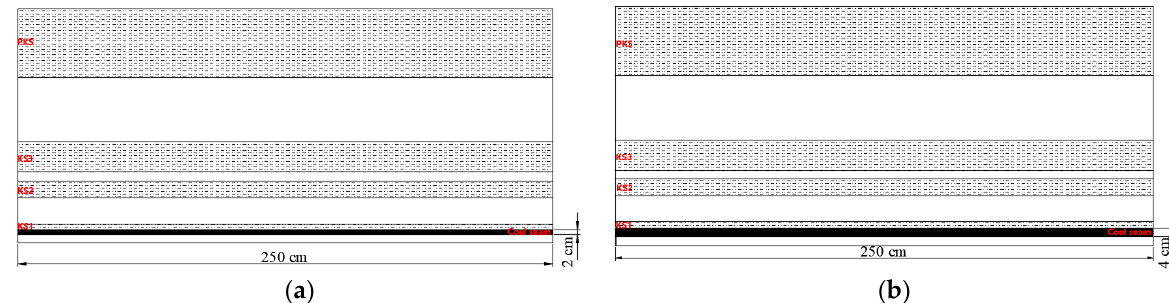
Figure 6. Different mining height physical model: ( a ) 2 cm mining height model; ( b ) 4 cm mining height model.